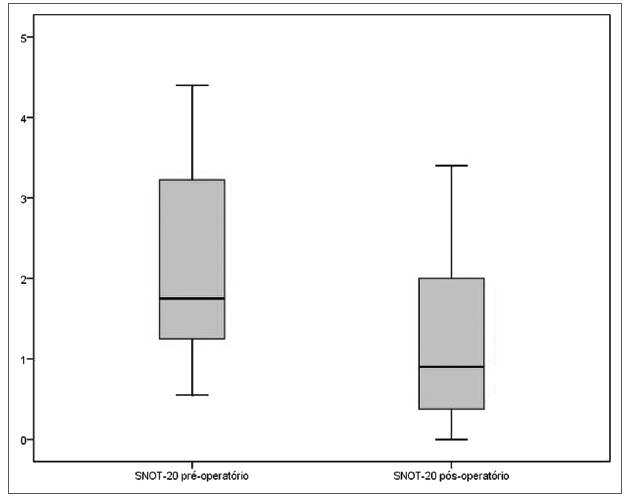
Figura 1. Pontuação total pré-operatória e pós-operatória no questionário SNOT-20 ( p <0,001).